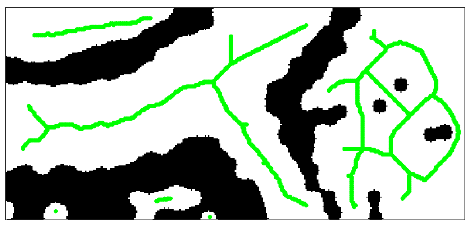
Figure 10. Skeletons of navigable regions.